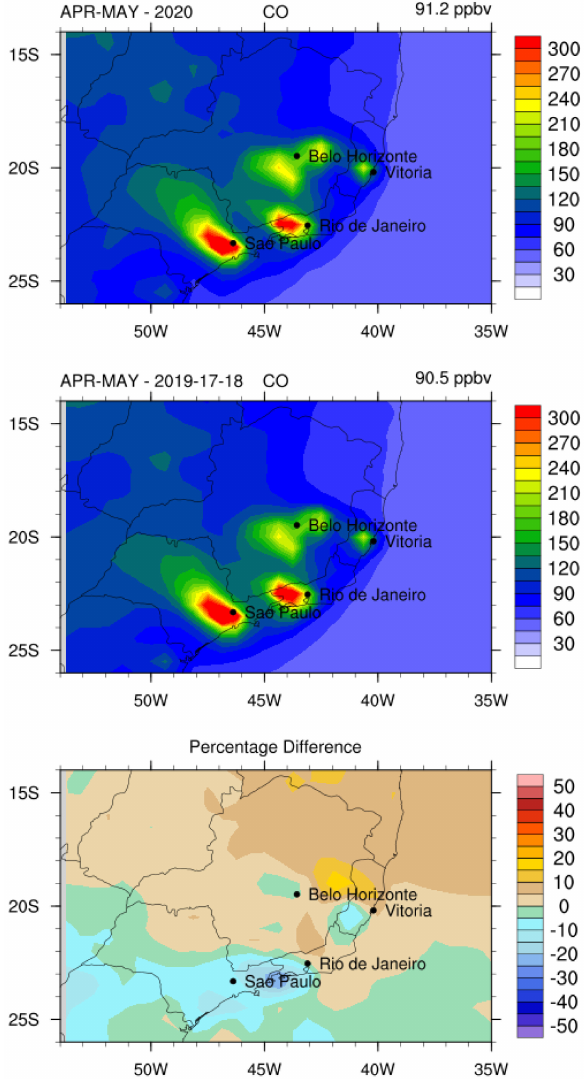
Figure 4. CO atmospheric concentrations near the surface for the period of April and May during the pandemic (2020) and pre-pandemic (2017–2019) from MERRA–2, and the percentage differences during the pandemic and pre-pandemic